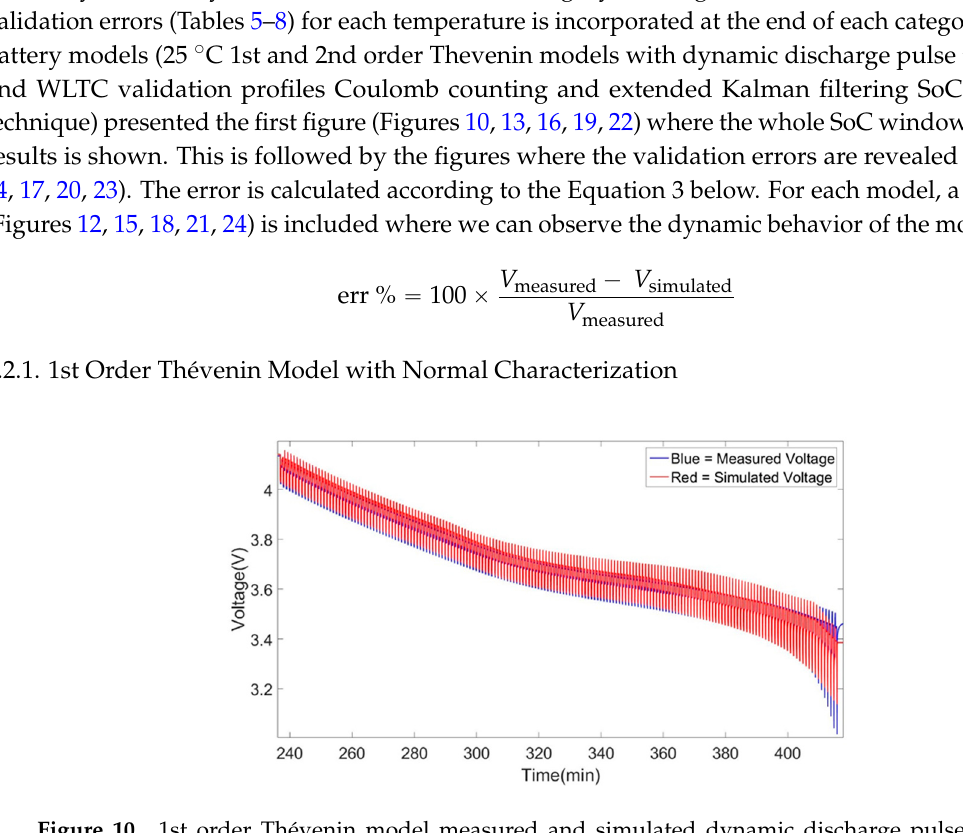
Figure 11. Error of the 1st order Thévenin model measured and simulated DDP comparison at 25 °C with Coulomb counting and normal characterization.